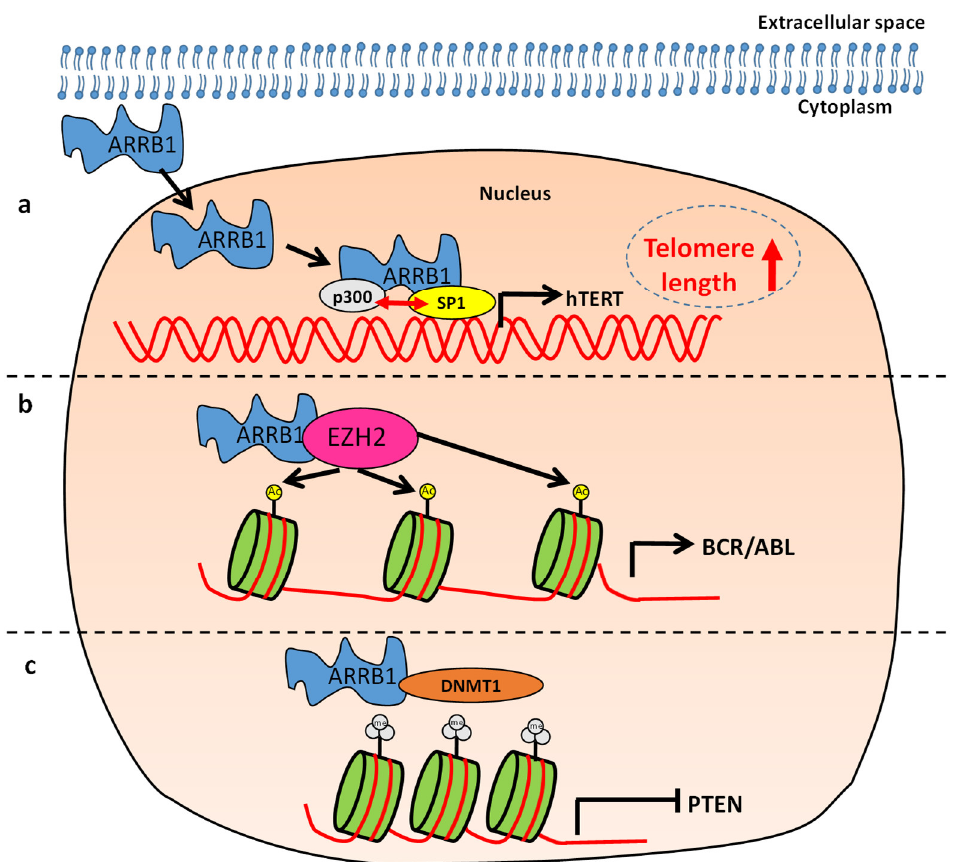
Figure 3. The role of β-arrestin1 (ARRB1) in regulating self-renewal and progression of myeloproliferative neoplasms. ( a ) ARRB1 promotes p300-SP1 interaction and SP1 mediated transcription of human telomerase reverse transcriptase (hTERT). Thus, ARRB1 is important for telomerase activity preventing the onset of cellular senescence in leukemia stem cells (LSCs). ( b ) ARRB1 facilitates enhancer of zeste homologue 2 (EZH2)-mediated acetylation of BCR/ABL histone H4, promoting progression of chronic myeloid leukemia. ( c ) ARRB1 facilitates the DNMT1-mediated methylation of the PTEN promoter region, promoting epigenetic silencing of PTEN and generation of leukemia stem cells in B-lineage acute lymphoblastic leukemia.